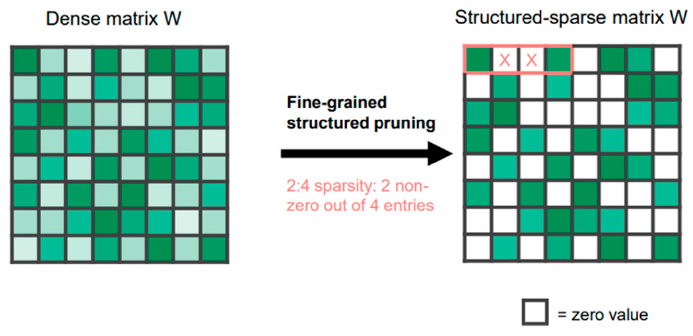
Figure 4. 2:4 Sparsity Structure.